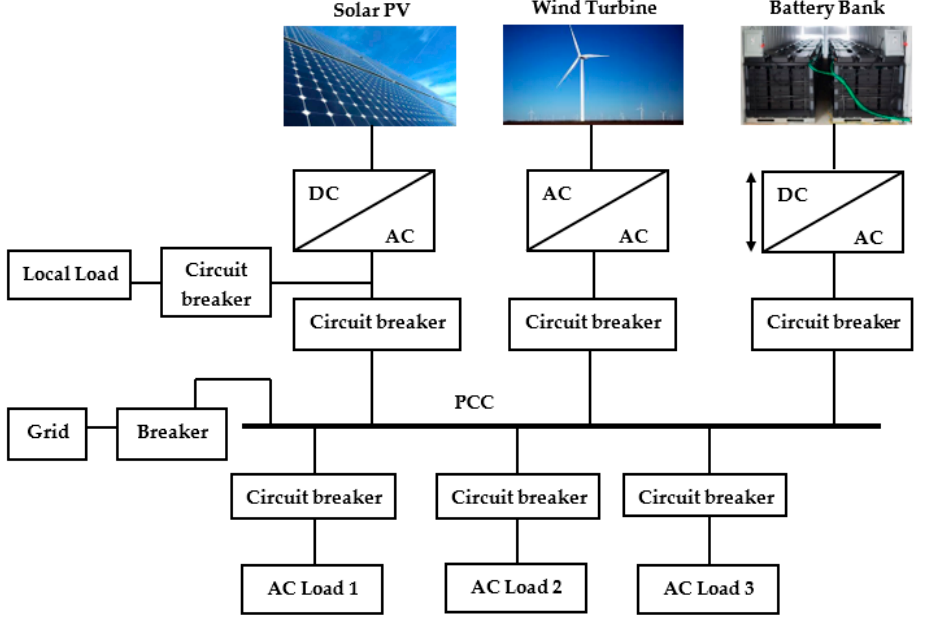
Figure 1. A general architecture of an MG.